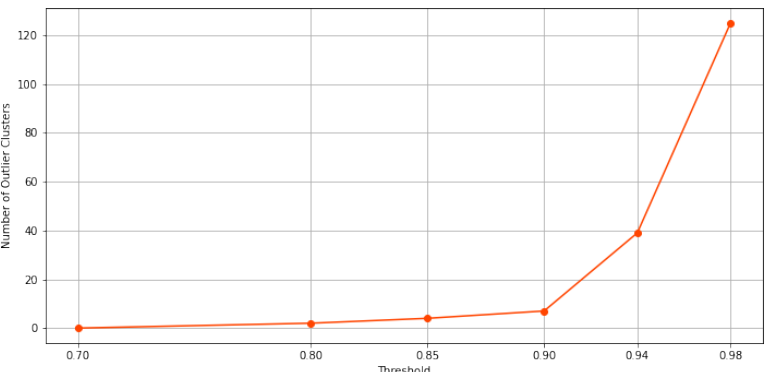
Figure 12. This figure shows, according to the filtering method, how many clusters in each ensemble solution are potentially